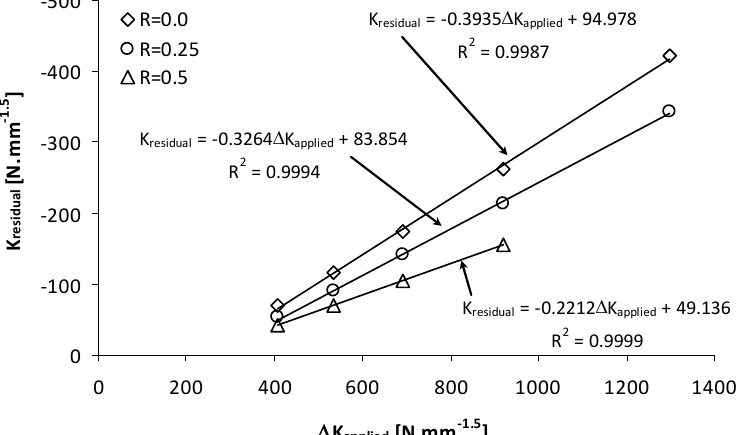
Figure 15: Residual stress intensity factor as a function of the applied stress intensity factor range obtained for the S355 steel ( ρ *=5.5×10 -5